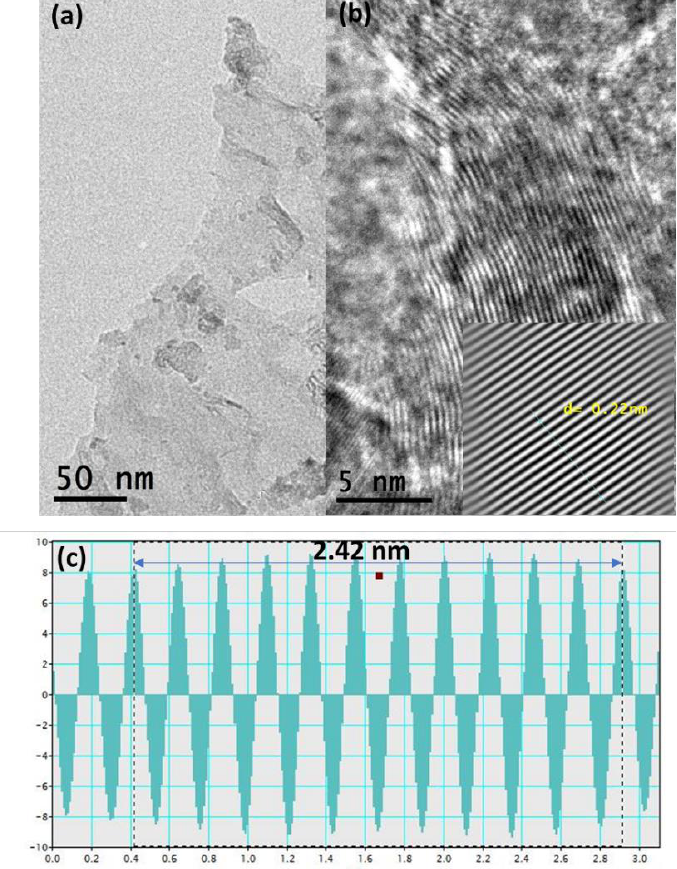
Figure 3. High-resolution TEM imaging of graphene. ( a ) TEM image of multilayer graphene, ( b ) lattice image of graphene, the inset is a magnified part where the atomic columns of the carbon are visible, the spacing of these lattice planes is 0.22 nm, and ( c ) The intensity profile shows the spacing between atomic lines, the spacing between 11 atomic planes is ~2.42 nm.